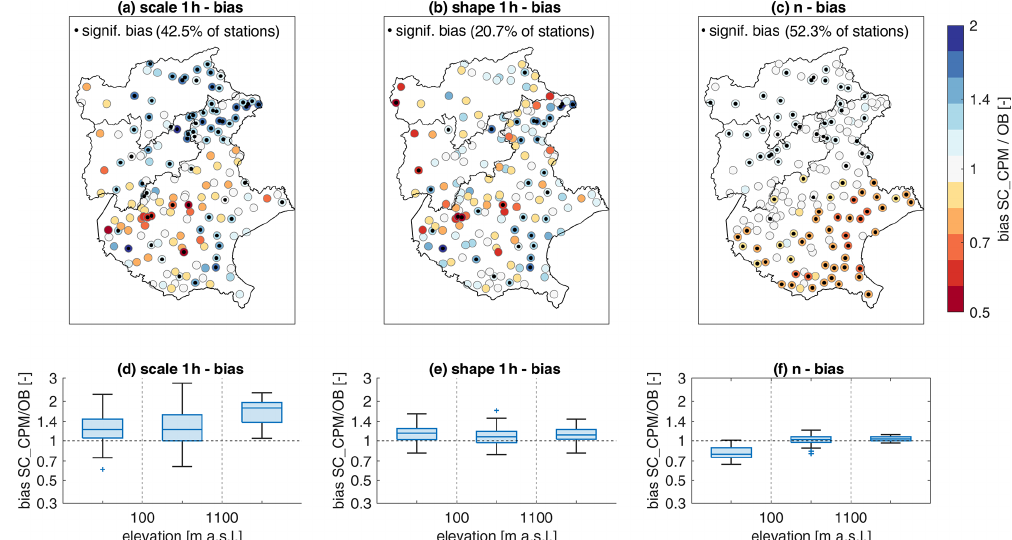
Figure 8. Maps and boxplot of the bias in the estimated SMEV distribution parameters: scale (a, d) , shape (b, e) , and n (c, f) . In all panels, significant differences at the 5% level are indicated by a black dot, and their proportion is reported as the percentage of significant cases on the total number of